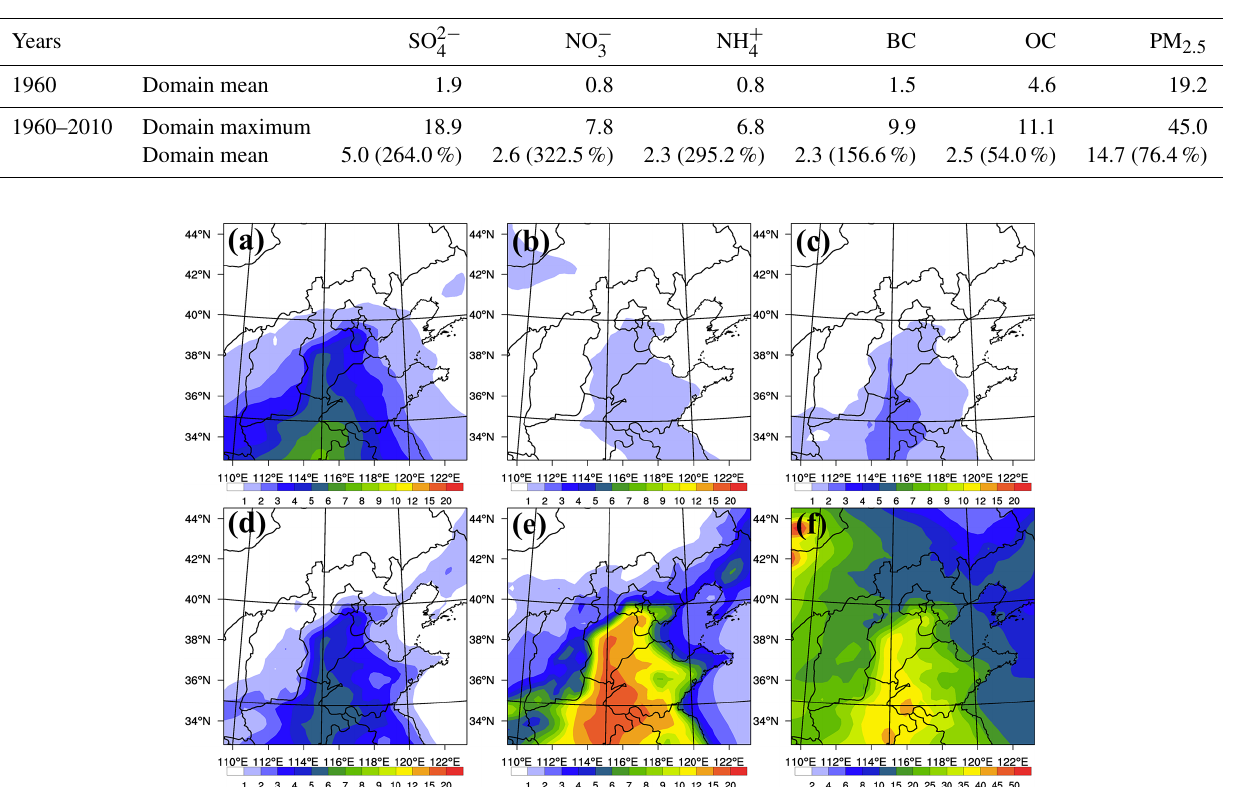
Table 2. Monthly domain mean concentrations of PM 2 . 5 and its major components for year 1960, and domain maximum and mean concen- trations for changes from 1960 to 2010 due to emission changes (µgm − 3 ).